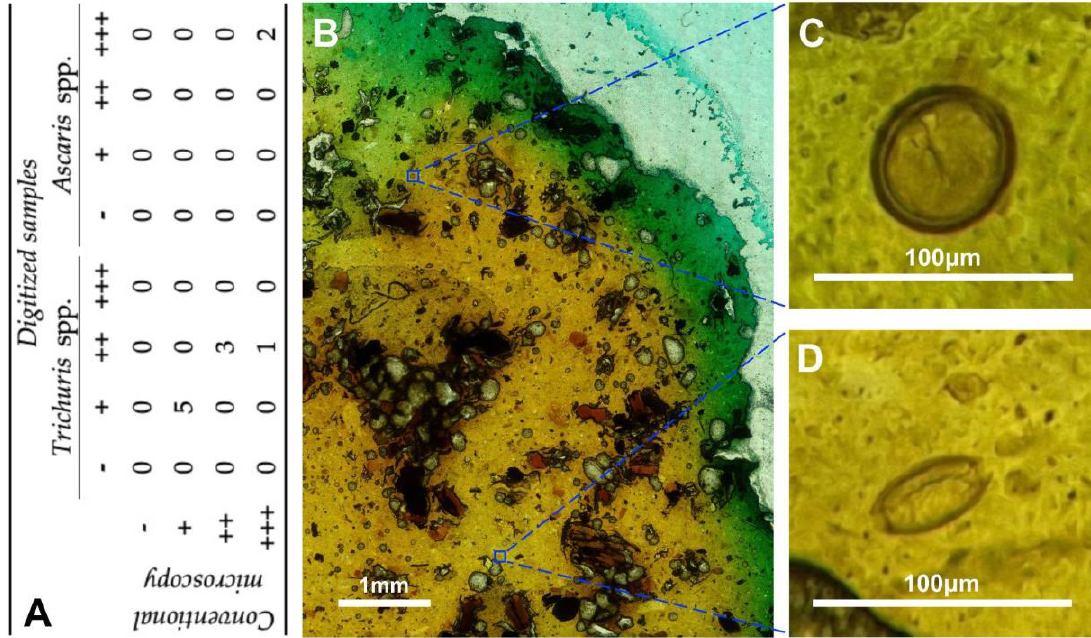
Figure 8. ( A ): Confusion matrix between intensity of infection performed by conventional microscopy and based on digitized samples. ( B ): Automated 20 × 20 grid scan from a Kato-Katz slide of a stool sample. ( C ): High magnification image showing Ascaris spp. egg. ( D ): Magnification image showing Trichuris spp. egg.